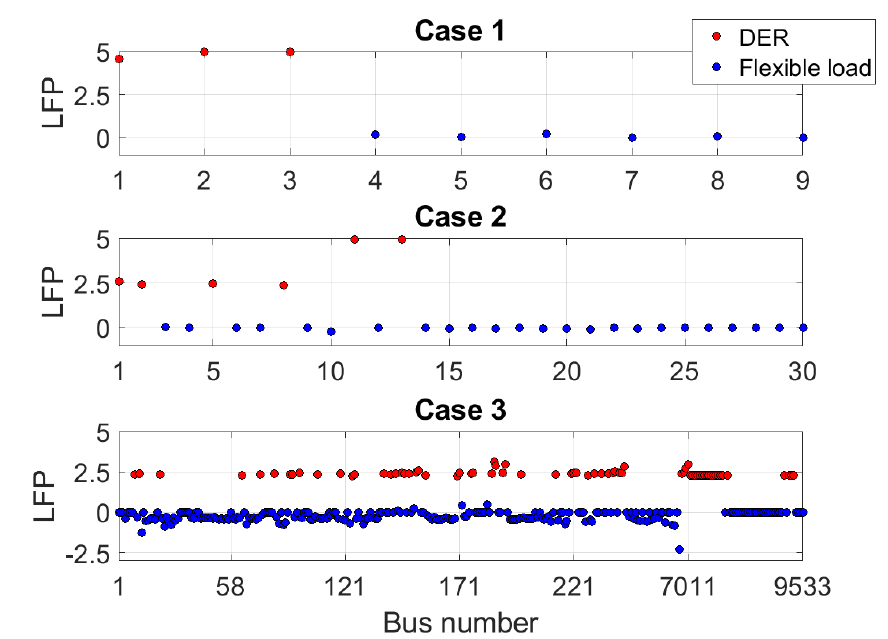
Figure 3. Locational Flexibility Price (LFP) ( A Ccent/kWh) for Case 1 ( top ), Case 2 ( middle ), and Case 3 ( bottom ). The red and blue dots represent a DER or a load bus, respectively.